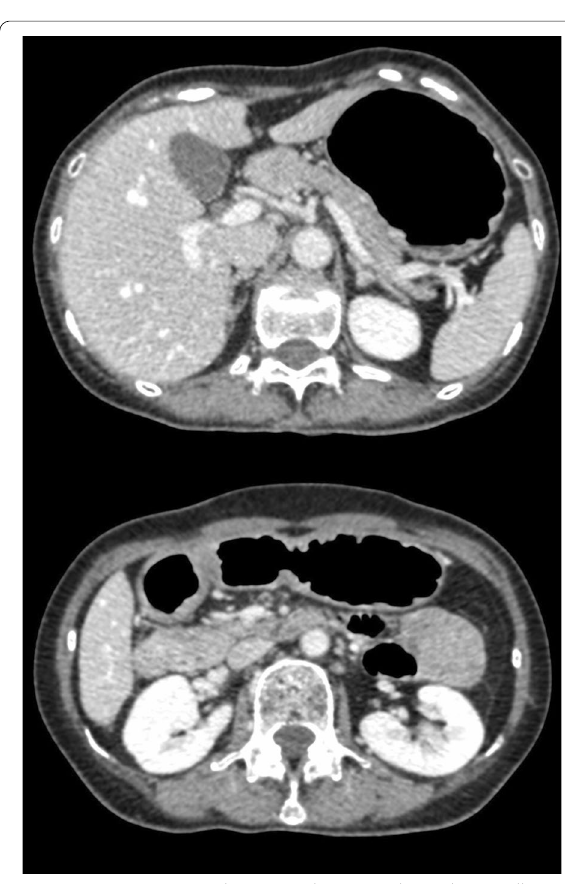
Fig. 2 Contrast computed tomography image showed no swelling lymph nodes or distantmetastasis